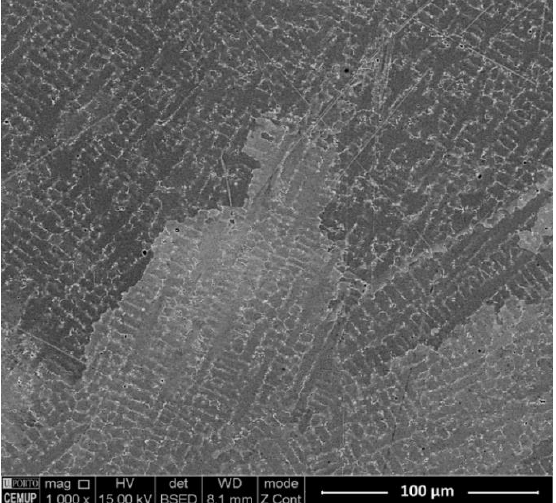
Figure 6. Microstructure of cladding produced by the I2_6_20 cladding condition on the preheated substrate, showing ( A ) substrate interface cladding zone. ( B ) A higher magnification illustration of the interface.